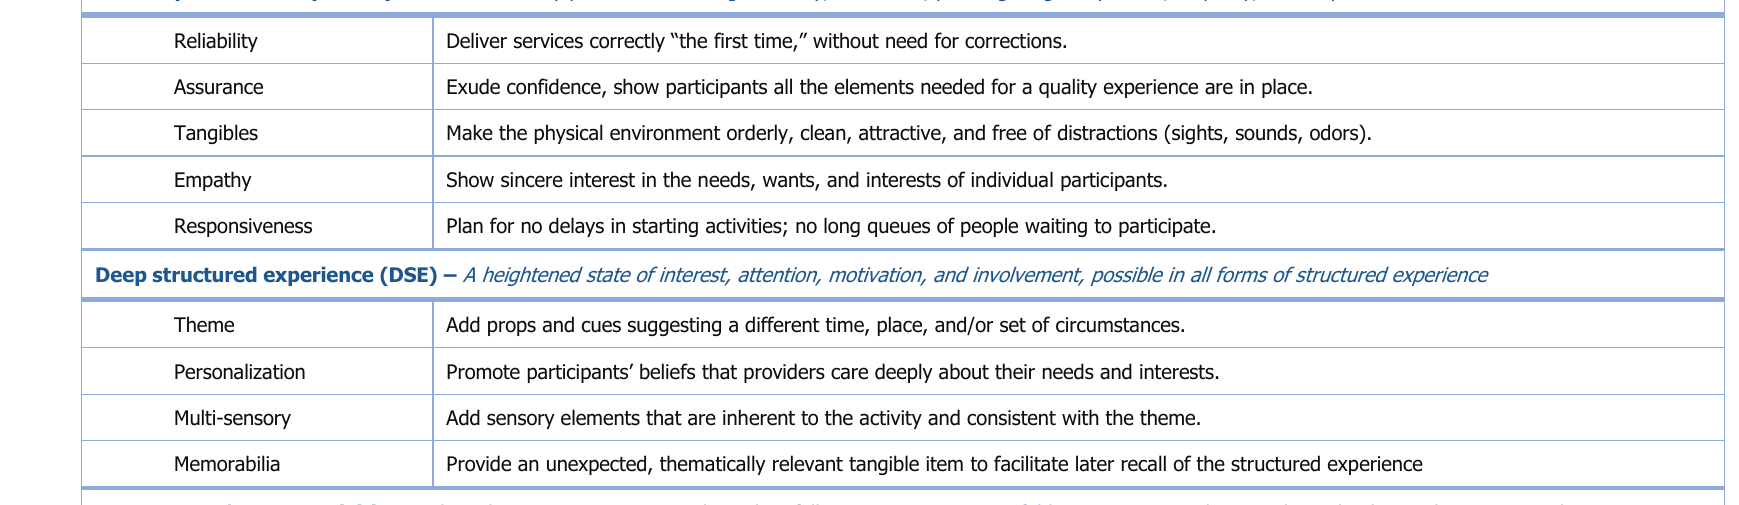
Table 1. Theory of Structured Experience Concepts and Strategies Service performance (RATER) – Actions taken by providers reflecting reliability, assurance, pleasing tangible qualities, empathy, and responsiveness